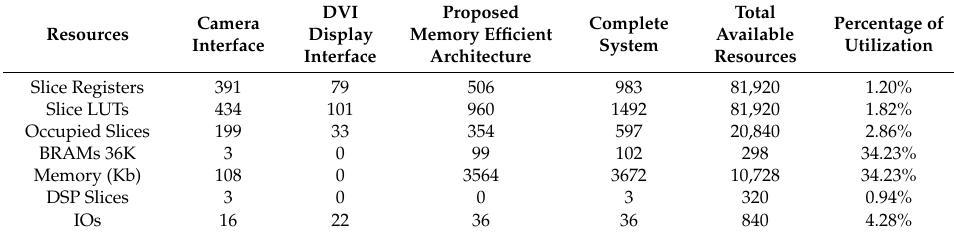
Table 2. FPGA Resource Utilization by Our Memory Efficient Motion Detection